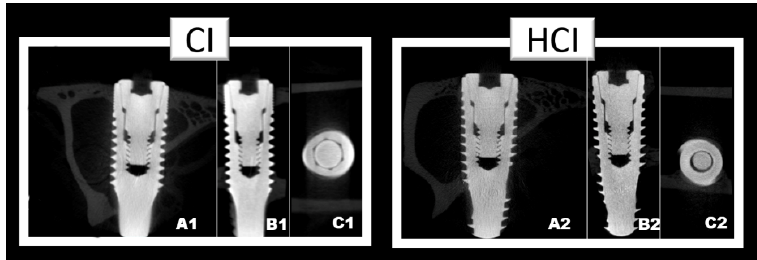
Figure 6. Microtomographic images representative of implants with different macrostructures CI: Cylindrical Implant (1) and HCI: hybrid conical implant (2). Axial slice ( A ); Sagittal slice ( B ); and Coronal slice ( C ).